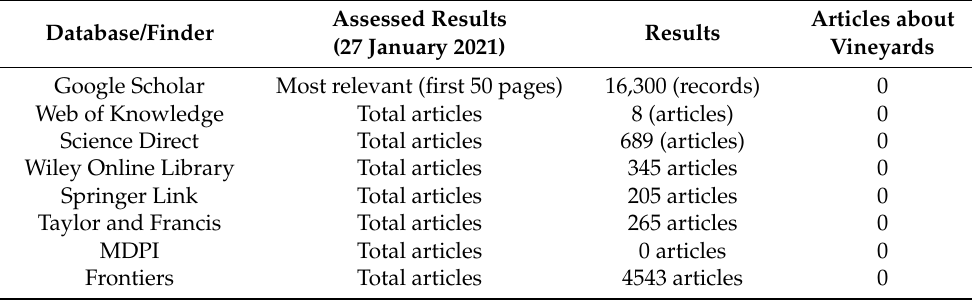
Table 2. Literature overview related to soil erosion in Chinese vineyards.